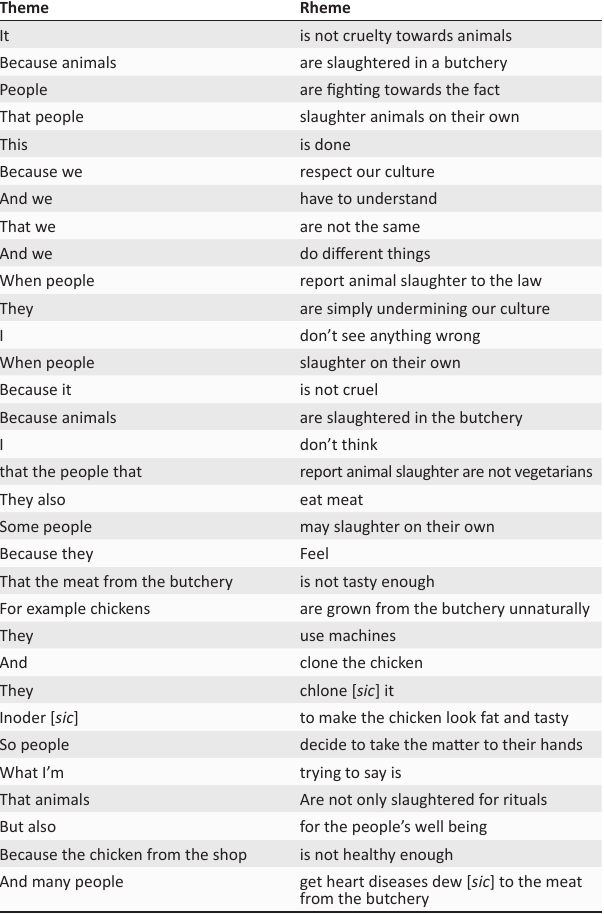
TABLE 1: Theme and rheme analysis.